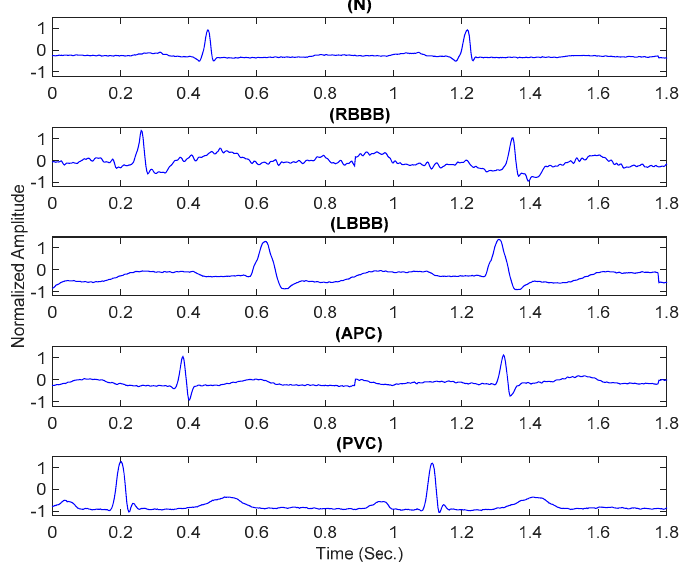
Figure 6. Examples of the pre-segmented electrocardiogram (ECG) signals.